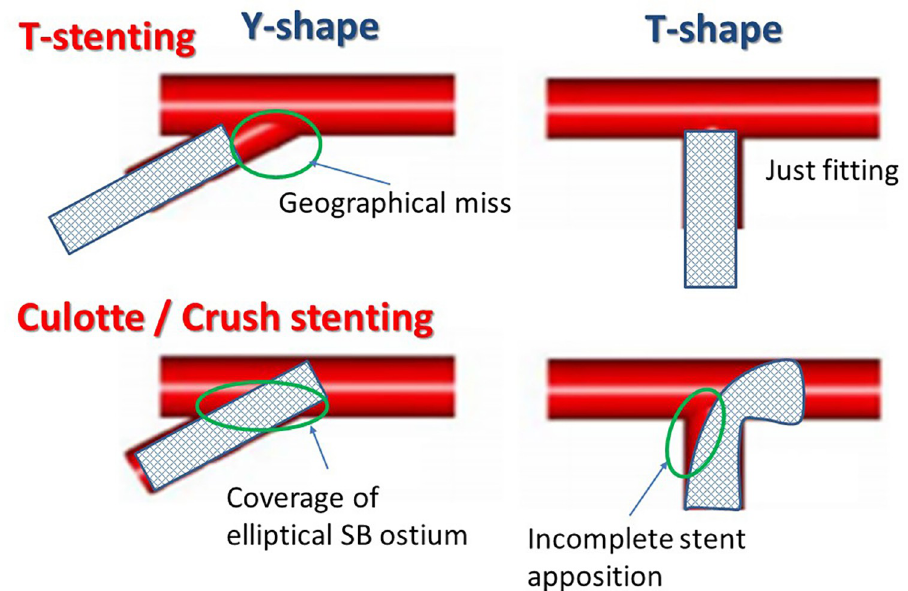
Fig 4. Favorable stenting technique in Y- and T- shape bifurcation lesions. In the Y-shape bifurcation, culotte or crush stenting is favorable due to complete coverage of the extended SB ostium. In the T-shape bifurcation, stenting crossing from the proximal MV to the SB is not suitable due to more frequent stent malapposition in the carinal area. See detail in the text.